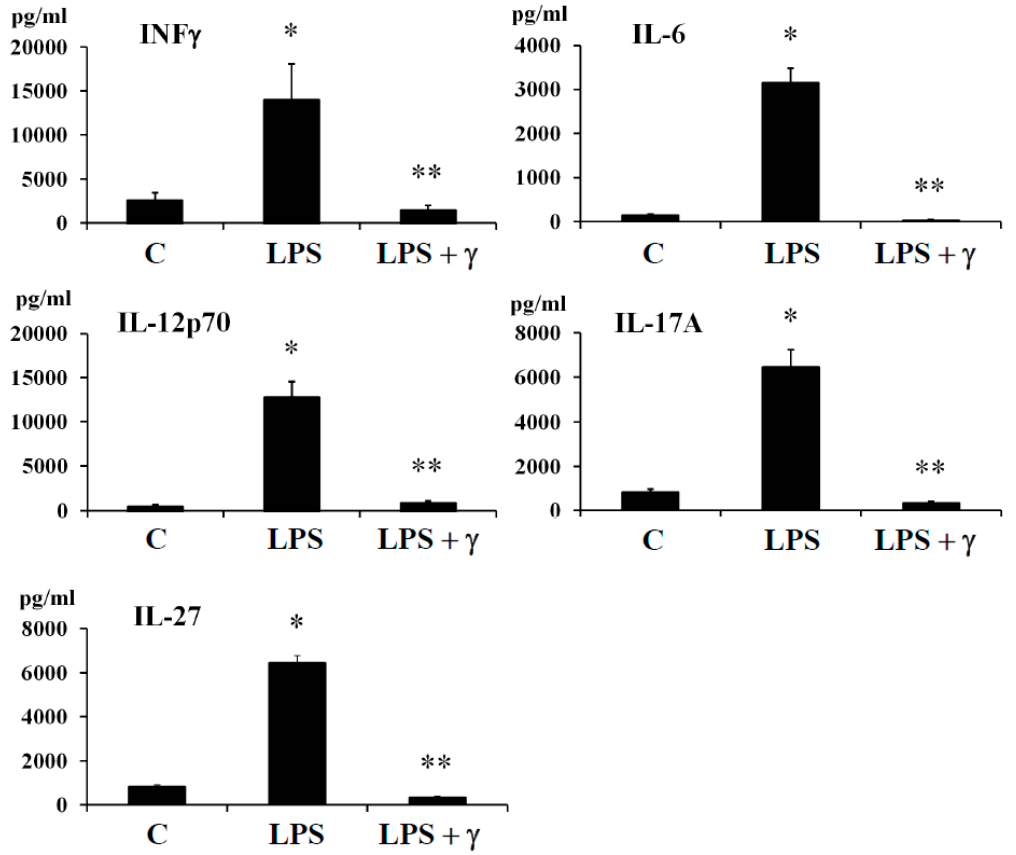
Figure 2. Effect of NLL γ -conglutin on the protein levels of pro-inflammatory cytokines. PANC-1 cells were incubated for 24 h with LPS alone, or γ -conglutin + LPS. The bar graph shows protein levels determined by ELISA of INF γ , IL-6, IL-12, IL-17, and IL-27. Data represent mean ± SD from three independent experiments. C: Untreated control culture cells; LPS: LPS-treated culture cells; LPS + γ : LPS + γ -conglutin challenge. p < 0.05 represents statistically significant di ff erences associated with each figure. p * < 0.05 LPS versus C; p ** < 0.05 LPS + γ -conglutin versus LPS. Challenges were made with LPS and / or γ -conglutin at 1 µ g / mL and 25 µ g,